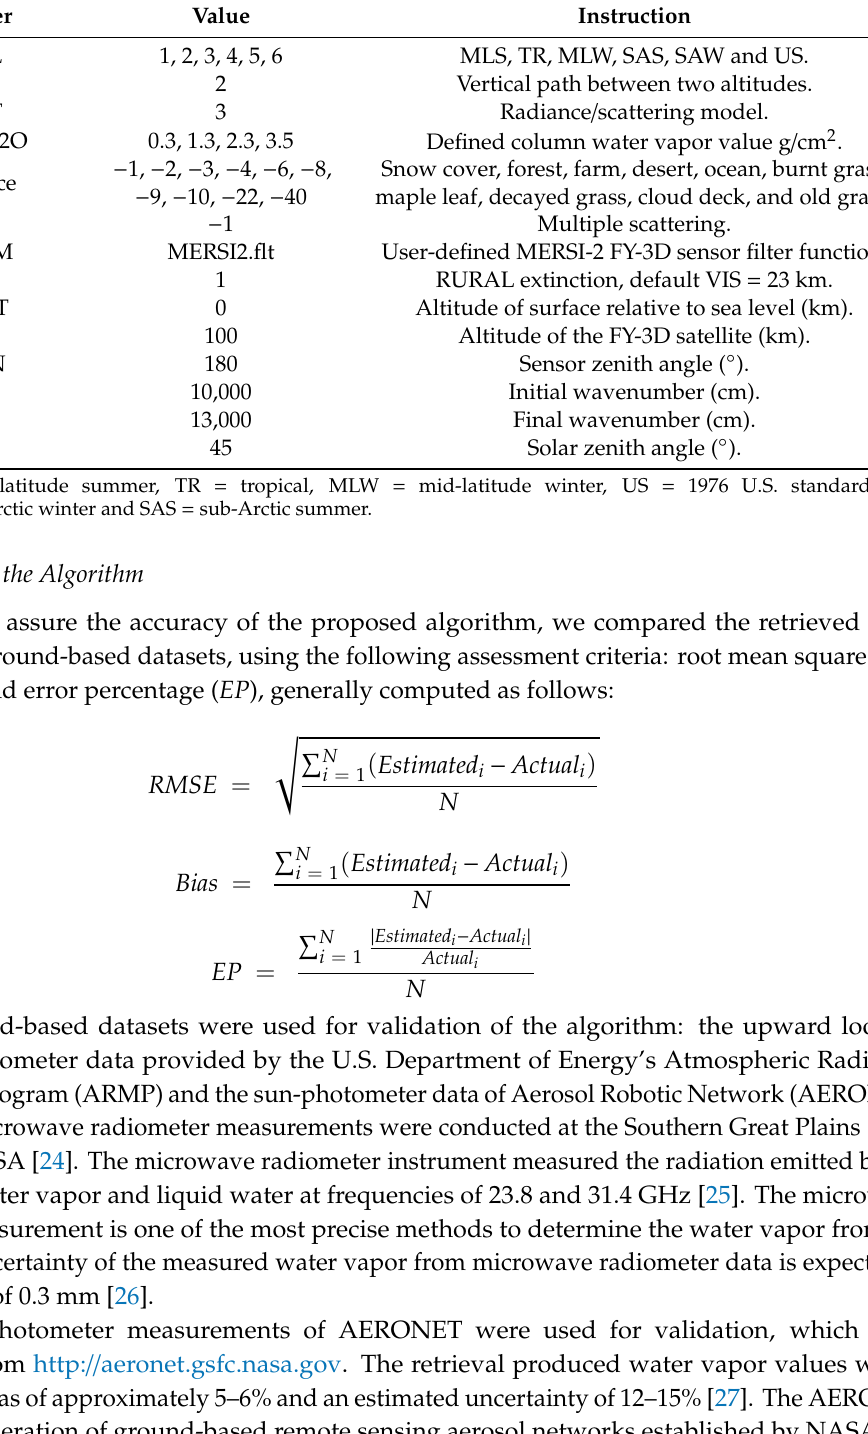
maple leaf, decayed grass, cloud deck, and old